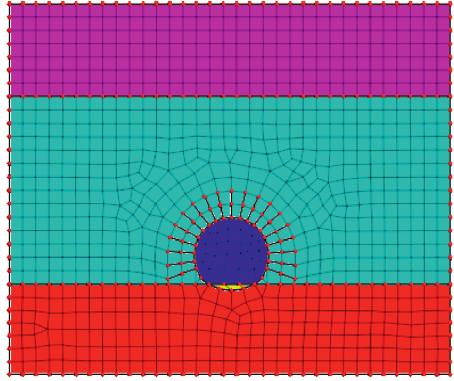
Figure 6: Mesh division.